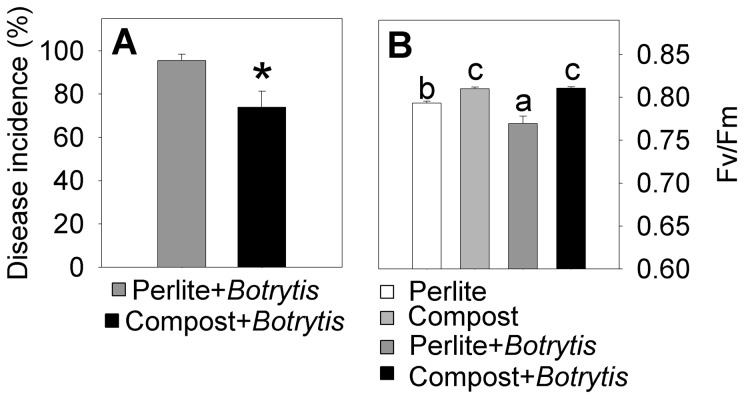
Percentage of infected leaves and Fv/Fm of Arabidopsis plants grown in perlite or compost.Percentage of infected leaves (A) and Fv/Fm (B) of Arabidopsis plants grown in perlite or compost 3 days after inoculation with Botrytis cinerea (3-µl drops of a 106 conidia mL−1 suspension was applied to alternate mature leaves). Control plants were treated with buffer without conidia. Bars represent the mean ± standard error (n = 10 for percentage of infected leaves and n = 6 for Fv/Fm). An asterisk indicates significant differences (P<0.05) in the ANOVA test. Different letters indicate significant differences in a Duncan's multiple-range test, P<0.05.